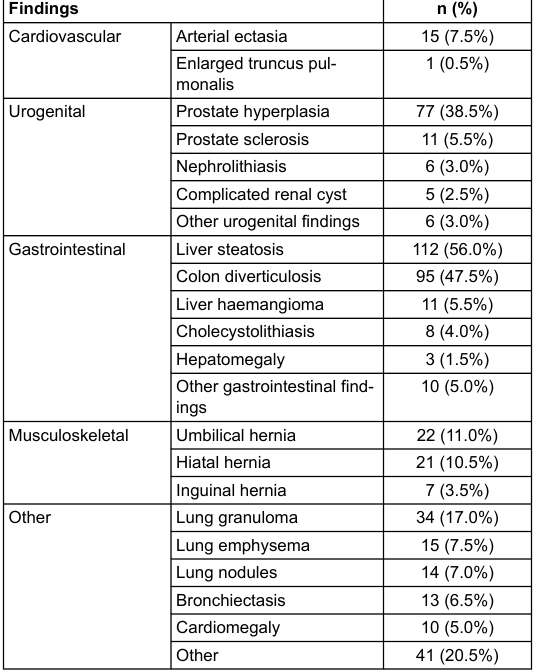
Table 3: Findings requiring deferred treatment in 175/200 patients with erectile dysfunction. Findings